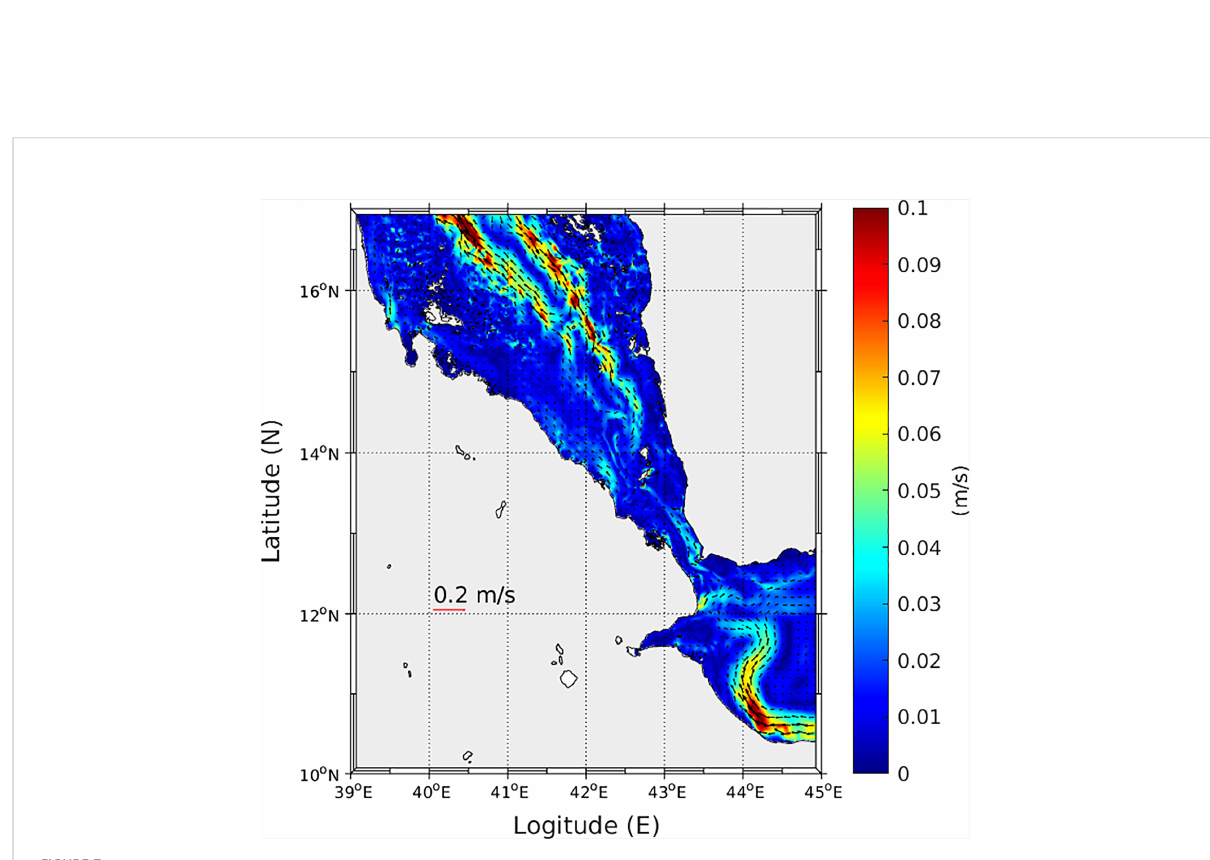
FIGURE 7 Tidal residual currents at the BAM strait and the southern Red